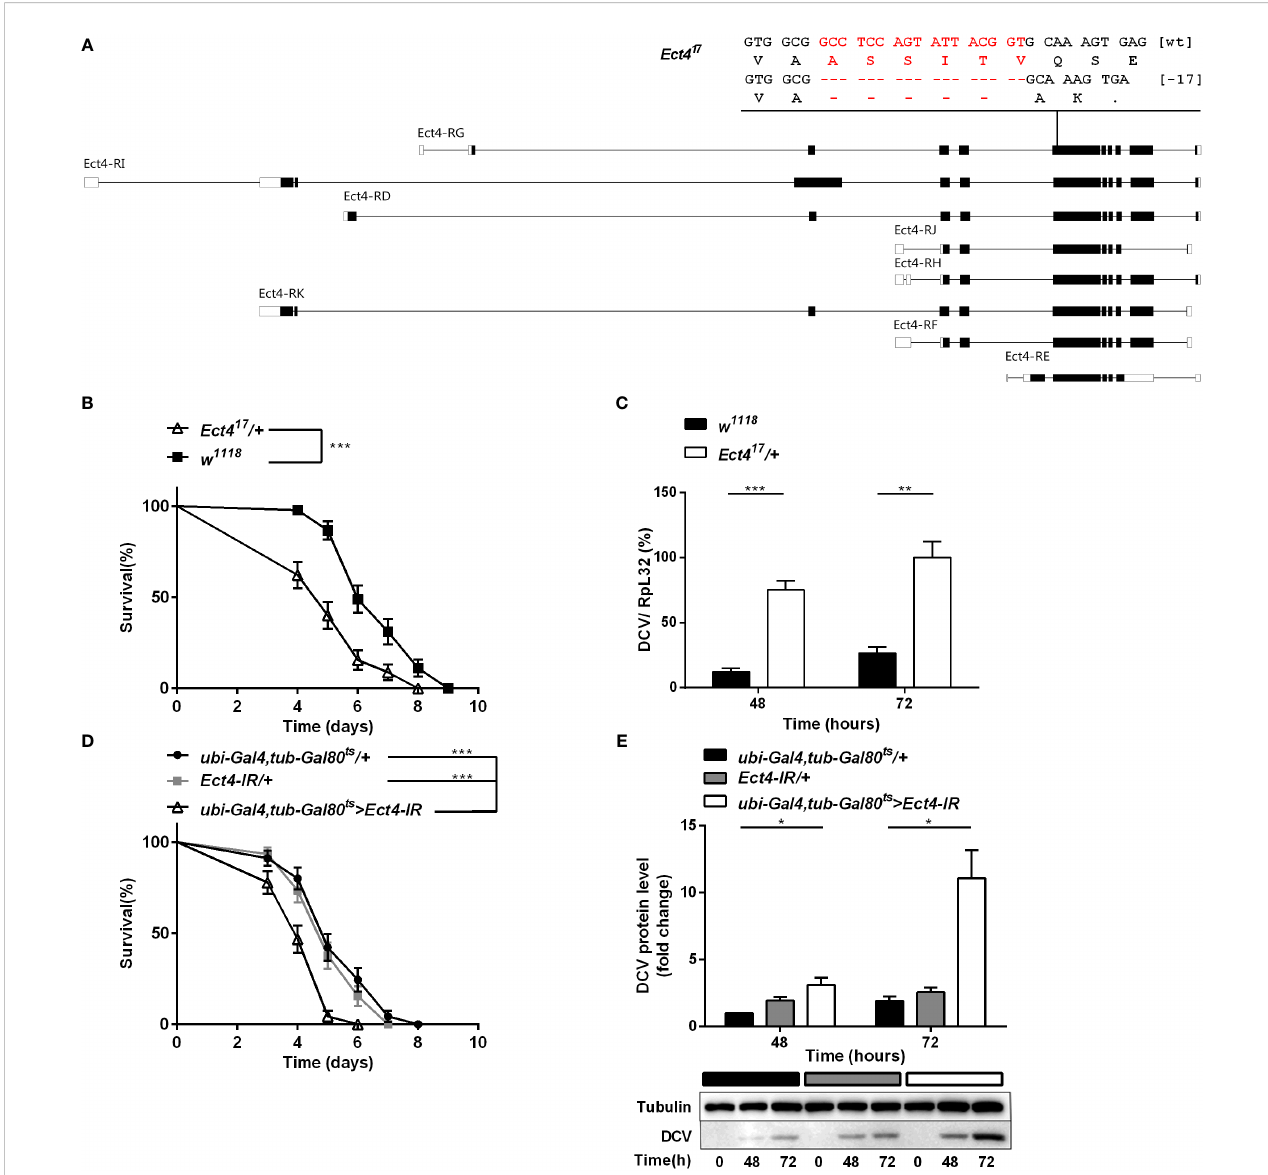
FIGURE 1 Depletion of Ect4 in adult fl ies leads to a reduction in viral resistance upon DCV infection. (A) Schematic representation of deletions at exon of Ect4 gene induced by CRISPR/Cas9. The deletion of 17 nucleotides (marked in red) caused a frameshift and created an early stop codons in the Ect4 17 mutant. Exons are represented by boxes, and introns by lines. UTRs are shown in white, and coding sequences are shown as black blocks. (B) Survival of Ect4 mutants and wild-type fl ies was monitored daily at 25°C. (C) Quantitative RT-PCR analysis of the accumulation of viral RNA at 48 and 72 h post-infection in wild-type and Ect4 mutant fl ies. (D) Survival of fl ies carrying the temperature-dependent Ect4 knockdown system and genetic control fl ies upon DCV infection at 29°C. (E) Immunoblot of the accumulation of DCV capsid polyprotein in Ect4 -RNAi or control fl ies, color blocks represented the genotype as indicated. Data represent the means ± standard errors of 3 independent pools of 15 male fl ies (B, D) or 10 male fl ies (C, E) for each genotype. Log-rank test (B, D) and t- test (C, E) : * P < 0.05, ** P < 0.01, *** P <